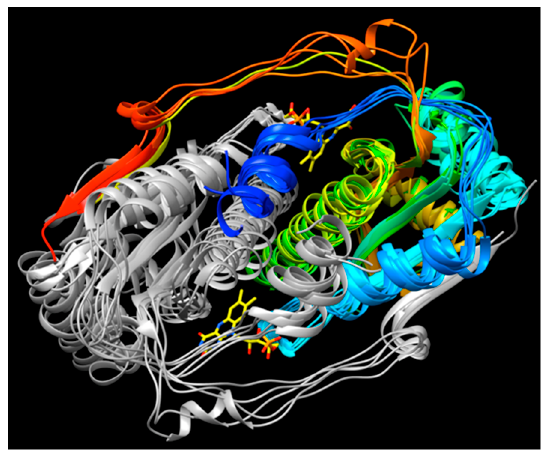
Figure 7. ‘Intertwining’, between domains of both the N and the C termini of the two chains. The A chain is colored according to a rainbow progression from blue at the N-terminus to red at the C-terminus; the B chain is in grey. The N-terminal helix of chain A nestles amid helices of chain B and C-terminal residues from chain A contribute a strand (red) to the beta sheet of domain B (left).